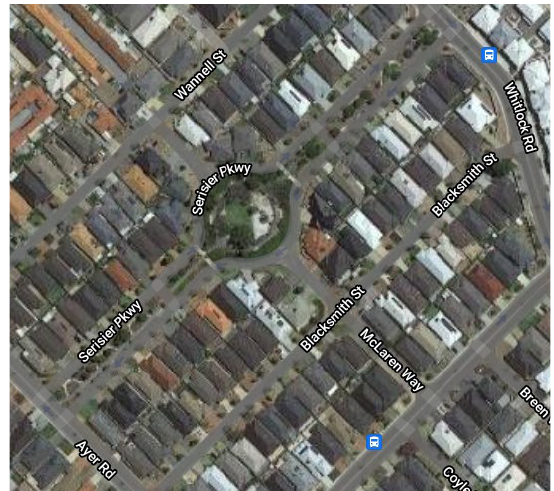
Figure 2: Aerial image of the sample area of the current Quattro Precinct subdivision (data source: